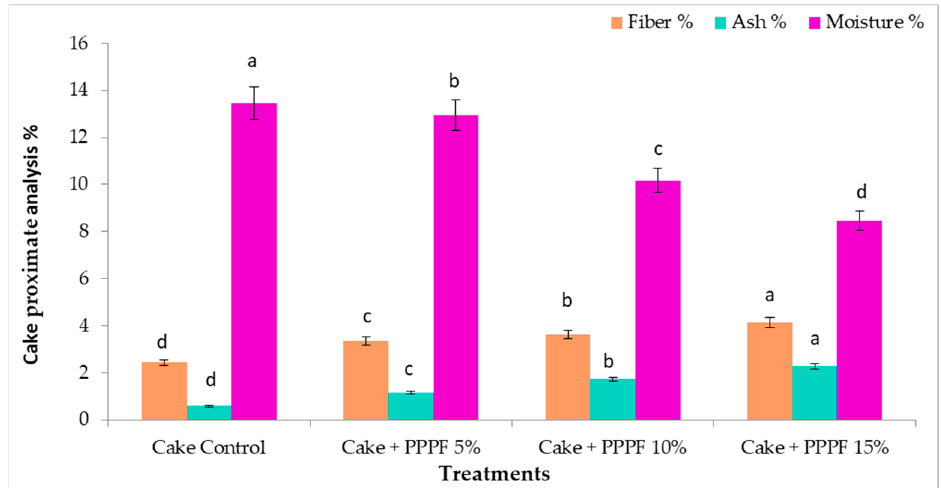
Figure 3. Proximate analysis of cake prepared by replacing flour with various levels of prickly pear peel flour (PPPF). Each value represents the mean (±SD) of three different replications. The differ- ent letters on the same bar show a significant difference according to Duncan’s test at p ≤ 0.05.